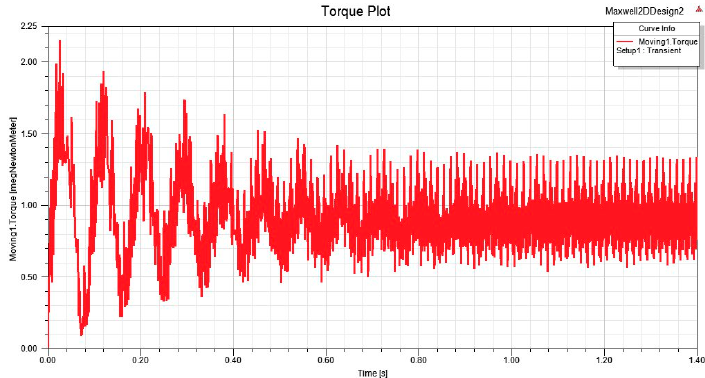
Figure 8. Curves for electromagnetic torque.